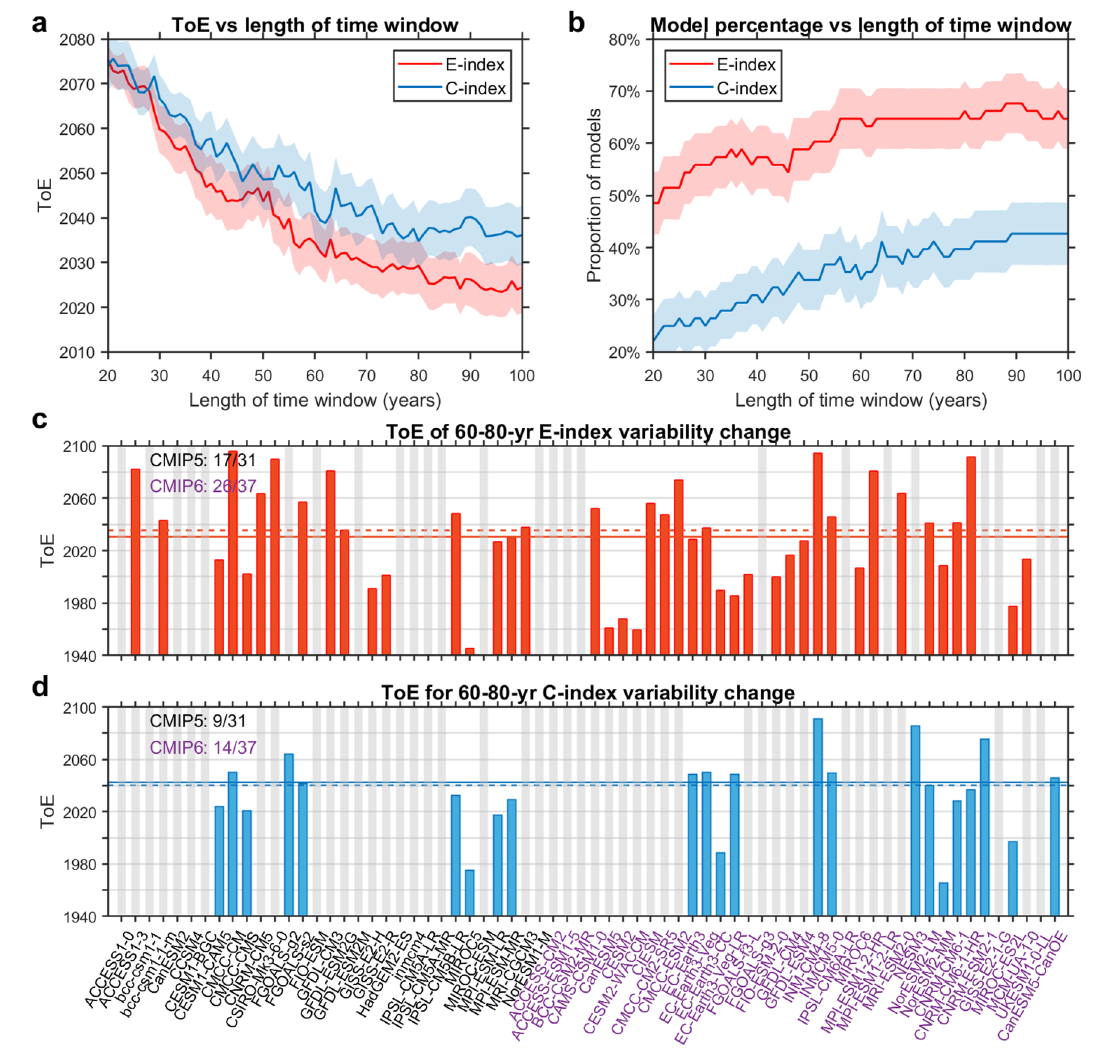
Fig. 2 | Earlier time of emergence (ToE) of eastern-Paci fi c El Niño-Southern Oscillation(EP-ENSO)thancentral-Paci fi c(CP)ENSO.a DependenceofToEupon length of time window over which signal and noise are diagnosed for E-index (red) and C-index (blue). b As in a , but for proportion (in percentage) of models that show emergence of E-index (red) and C-index (blue) before 2100. Solid lines and shadings indicate multi-model mean and one standard deviation of a total of 10,000 inter- realisations, respectively, based on a Bootstrap method (see Methods). c ToE